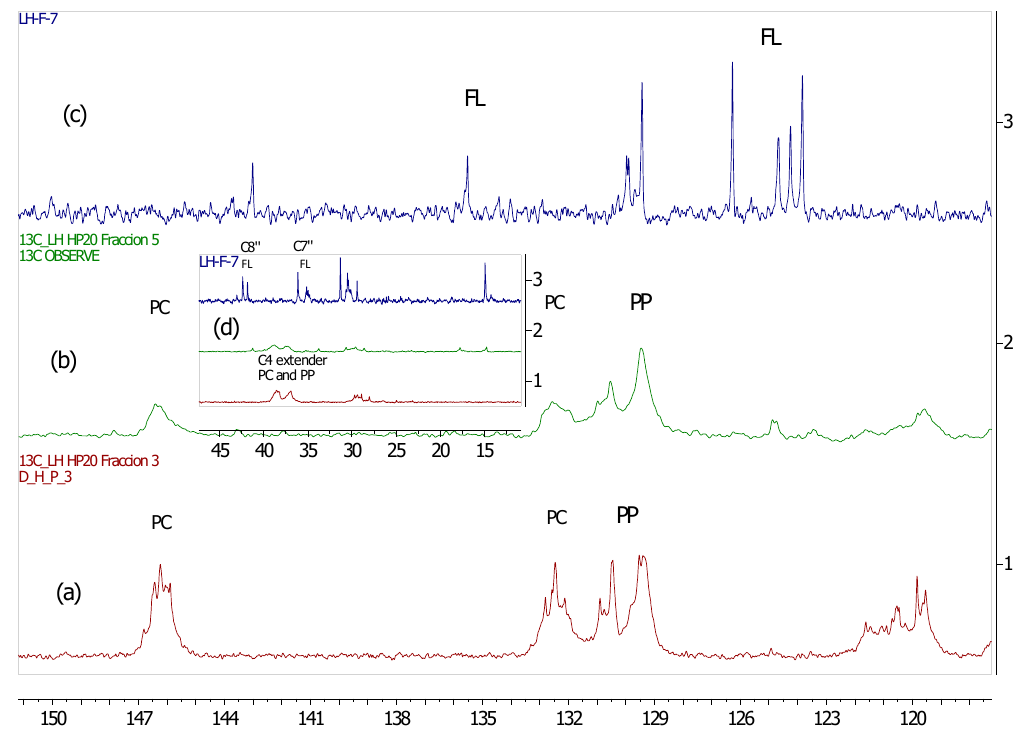
Figure 5. 13 C-NMR (MeOD) for different fractions of leaves from U. tomentosa: ( a ) fraction LH-F3; ( b ) fraction LH-F5; ( c ) fraction LH-F7 and ( d ) amplification for the three fractions in the range of δ 45–15 ppm.